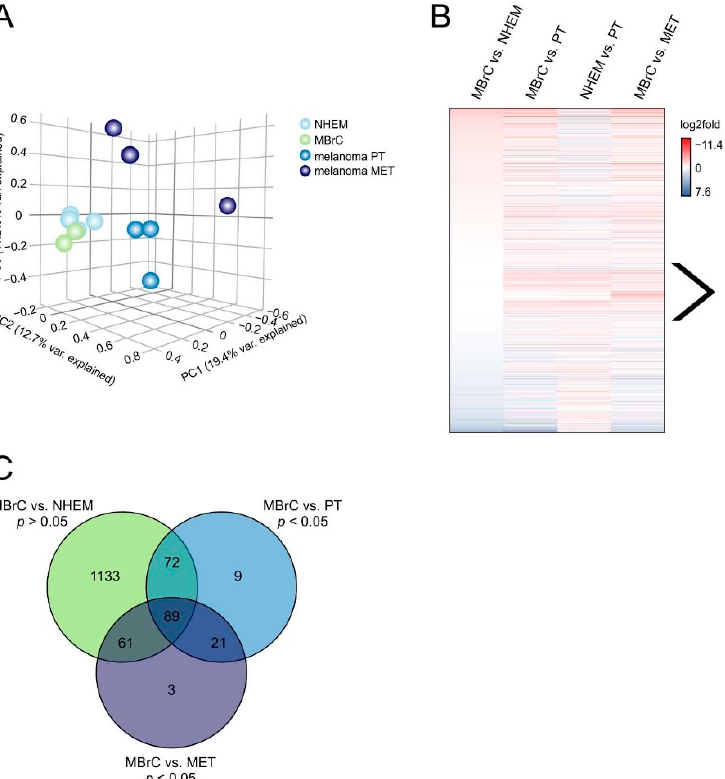
Figure 1. miRNA sequencing in NHEMs, MBrCs, and melanoma cell lines reveals a group of miRNAs, which are strongly regulated only in melanoma. ( A ) Principal component analysis of miRNA-seq data plot of the first three principal components (PCs). Samples with related gene expression profiles are closer in the three-dimensional embedding. Each sphere represents an RNA-seq sample, and replicates are shown in the same color: NHEM ( n = 4), MBrC ( n = 2), melanoma primary tumor (PT) cell lines Mel Juso, Mel Wei and Mel Ei, melanoma metastasis (MET) cell lines Mel Im, Mel Ju and Hmb2. ( B ) Differential gene expression analysis of miRNA-seq data in the indicated sample pairs is shown as a heatmap of log2fold values. The arrow indicates miRNAs, which are equally expressed in MBrCs and NHEMs but strongly upregulated in melanoma cell lines. ( C ) Venn diagram of miRNAs that are not significantly differentially expressed in MBrCs vs. NHEMs ( p -value > 0.05) but significantly differentially expressed ( p -value < 0.05) in MBrCs vs. melanoma primary tumor (PT) or metastasis-derived (MET) melanoma cell